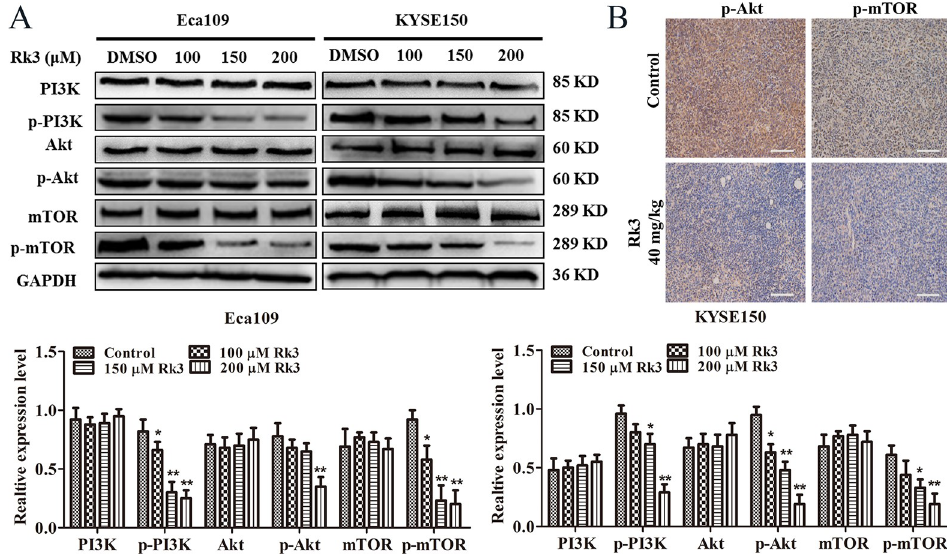
Fig 5. Rk3 suppresses the PI3K/Akt/mTOR pathway in Eca109 and KYSE150 cells. (A) Cells were treated with differernt concentrations of Rk3 for 24 h, and the expression of PI3K, p-PI3K, Akt, p-Akt, mTOR and p-mTOR was determined by western blotting. (B) Immunohistochemical staining of tumor tissue. � p < 0.05, �� p < 0.01 compared with the control.